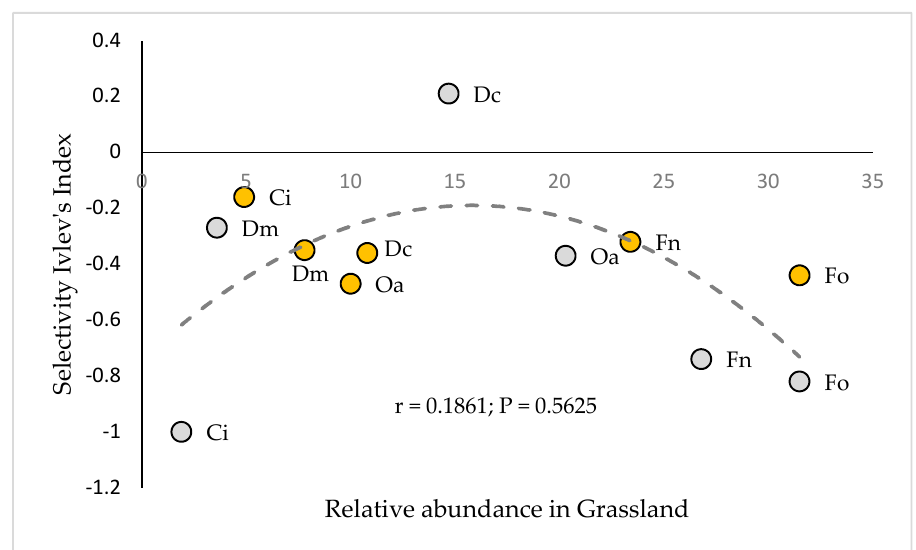
Figure 6. Relationship between the relative abundance of the species in the prairie and its corresponding selectivity index, measured in the months of January (wet–summer season) and July (dry–winter season). Fo= Festuca orthophylla ; Dc= Deyeuxia curvula ; Fn= Festuca nardifolia ; Ci= Carex incurva ; Oa= Oxychloe andina ; Dm= Distichia muscoides . Orange circles correspond to January measurements and gray circles correspond to July measurements.